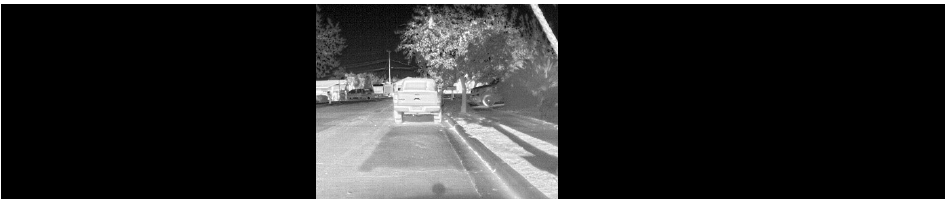
Figure 7. Random padding added to FLIR dataset images for